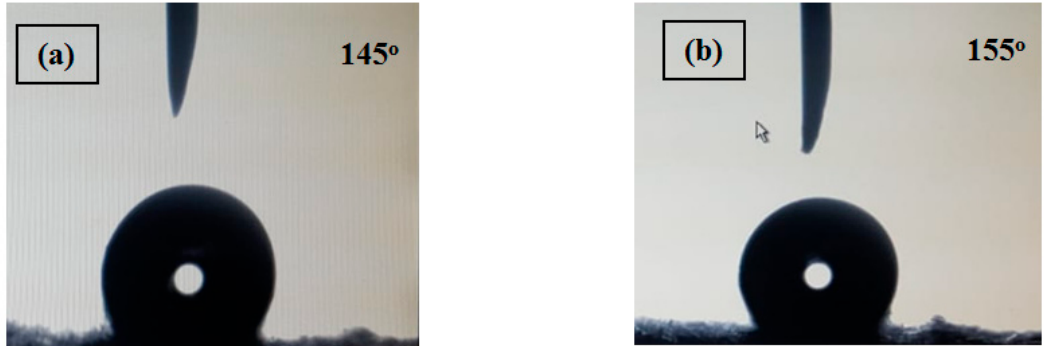
Figure 1. SEM images of ( a ) polystyrene (PS) blank membrane and ( b ) PS/multiwalled carbon nanotubes (MWCNTs) composite membranes.